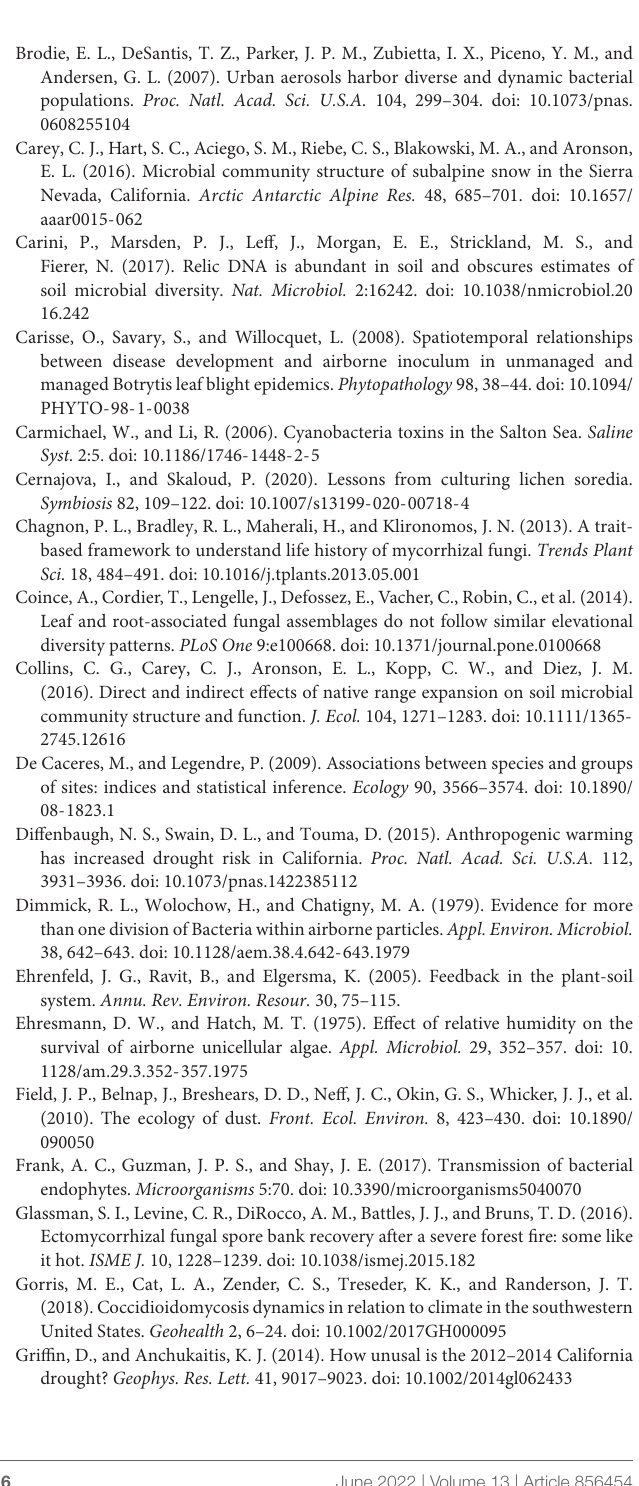
Supplementary Table 1 | Site and sampling characteristics. Coordinates, elevation, and deployment dates for each of four sites in the elevation gradient in the Sierra Nevada of California. The International Geo Sample Number